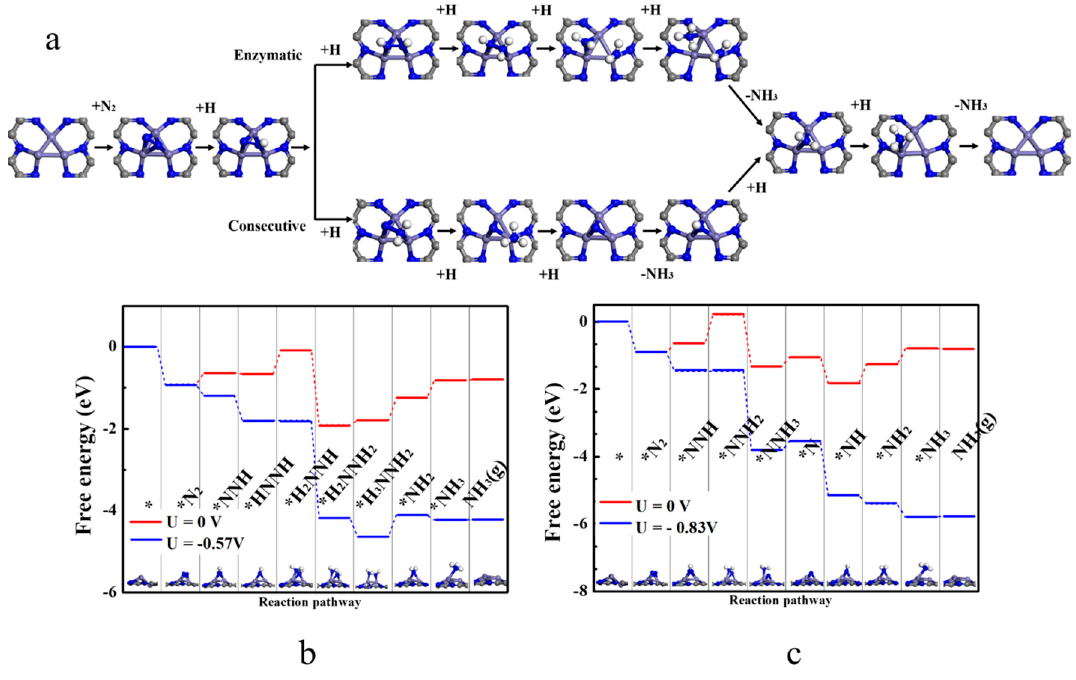
Figure 3. ( a ) Two nitrogen reduction reaction (NRR) pathways on Fe 3 @C 2 N, and the free energy diagram through enzymatic ( b ) and consecutive mechanisms ( c ) at different limiting potentials.